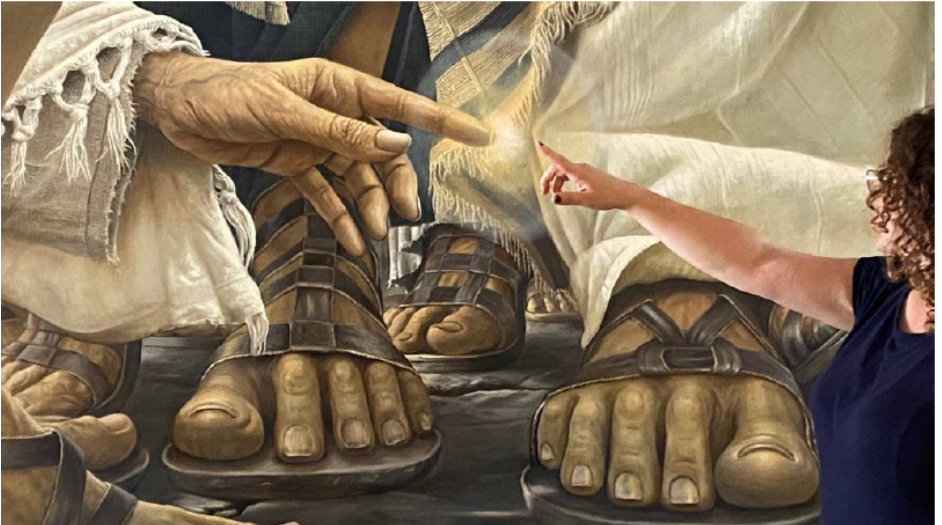
Figure 16. The fresco with visitor, moment of “encounter” enacted using cellular camera (photo: Assaf Pinkus).